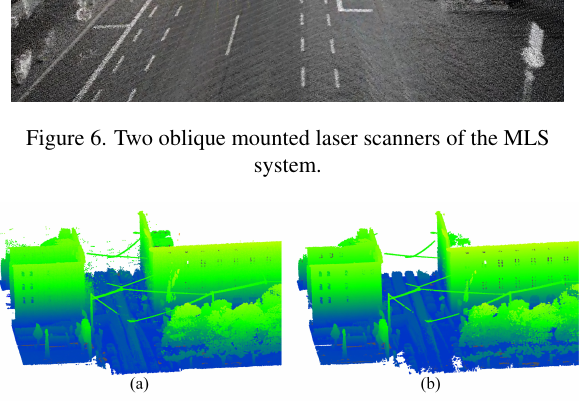
Figure 7. (a) Raw point clouds. (b) Preprocessed point